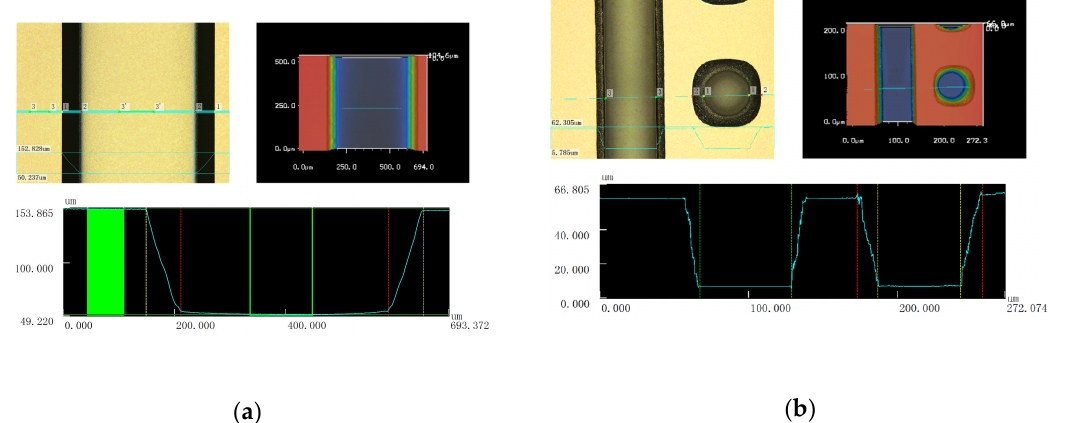
Figure 13. Three-dimensional microscope image of ( a ) the silicon trench and ( b ) the trench and tapered via. Table 5. The top opening and depth of the trench in E2 process.